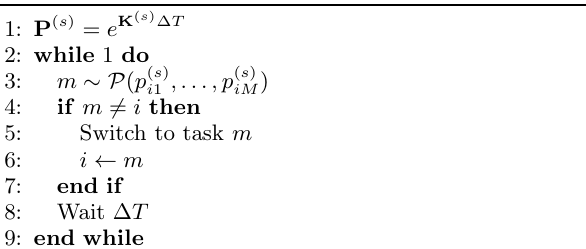
Algorithm 1 Robot Controller ( K ( s ) , ∆ T )